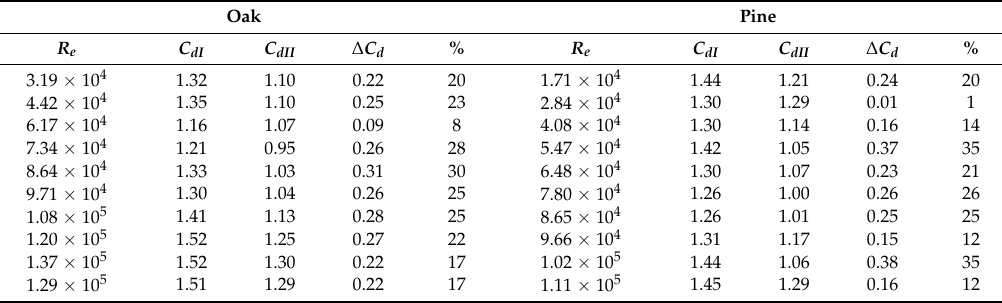
Table 4. Comparison of results flow resistance coefficient C d for oak and pine.